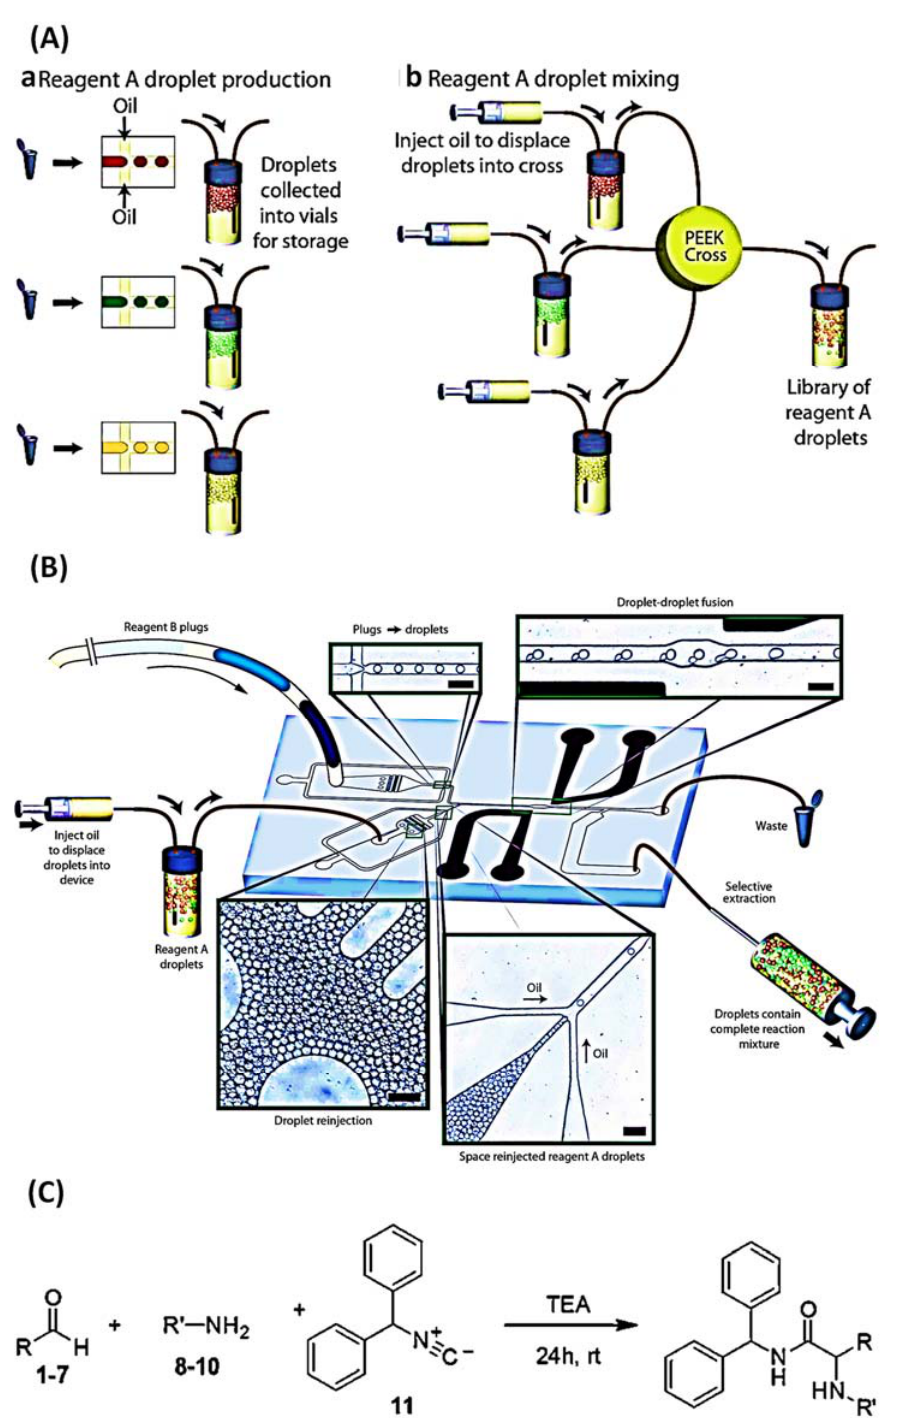
Figure 2. Schematic representation of the synthesis of active molecules with the potential to inhibit thrombin by a Droplet microreactor: ( A ) Schematic diagram of the reagent A droplets. ( B ) Schematic diagram of chemical synthesis by injection of microdroplets. ( C ) Schematic representation of the synthesis of molecules with potential prothrombin ‐ inhibiting activity by amines, aldehydes, and isocyanides. The image from [38], Copyright 2012, Royal Society of Chemistry.